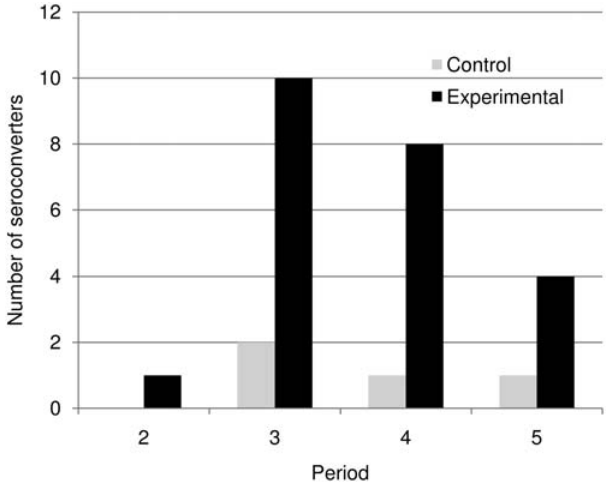
Figure 4. Number of individual Z.brevicauda and O.fulvescens seroconverting (transitioning from seropositive to seronega- tive) in experimental (non-reservoirs removed) and control (unmanipulated) plots.